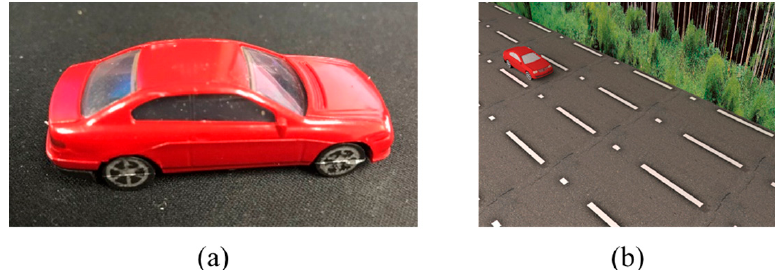
Figure 9. Virtual test configuration. ( a ) Scanned model car; ( b ) synthetic image modeling by 3DS Max.